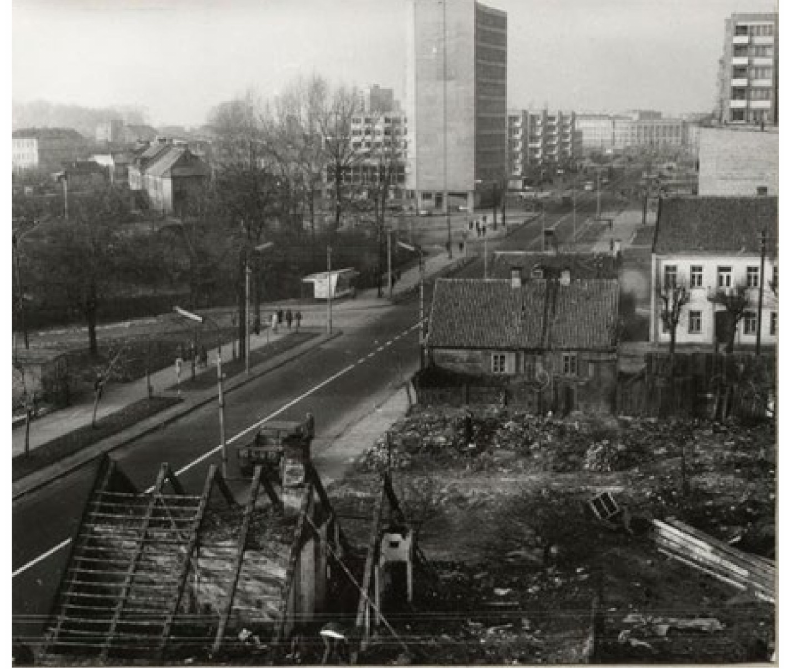
Figure 2. M. Skłodowska-Curie Street completed in the 1950s–1960s of the 20th century and a mixture of buildings (Archives of Urban Planning Department, Białystok